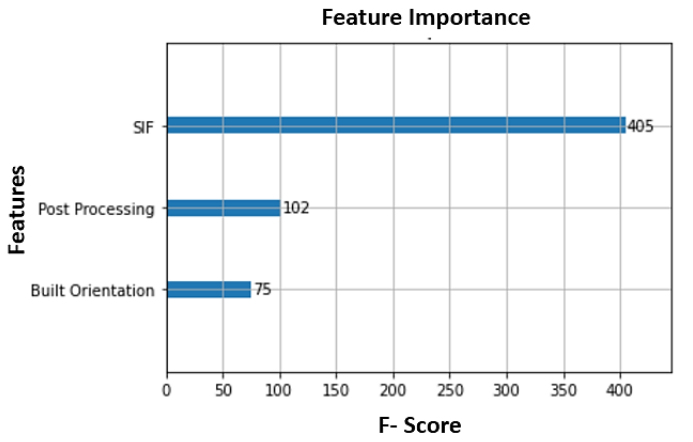
Figure 7. Feature Importance Ranking.